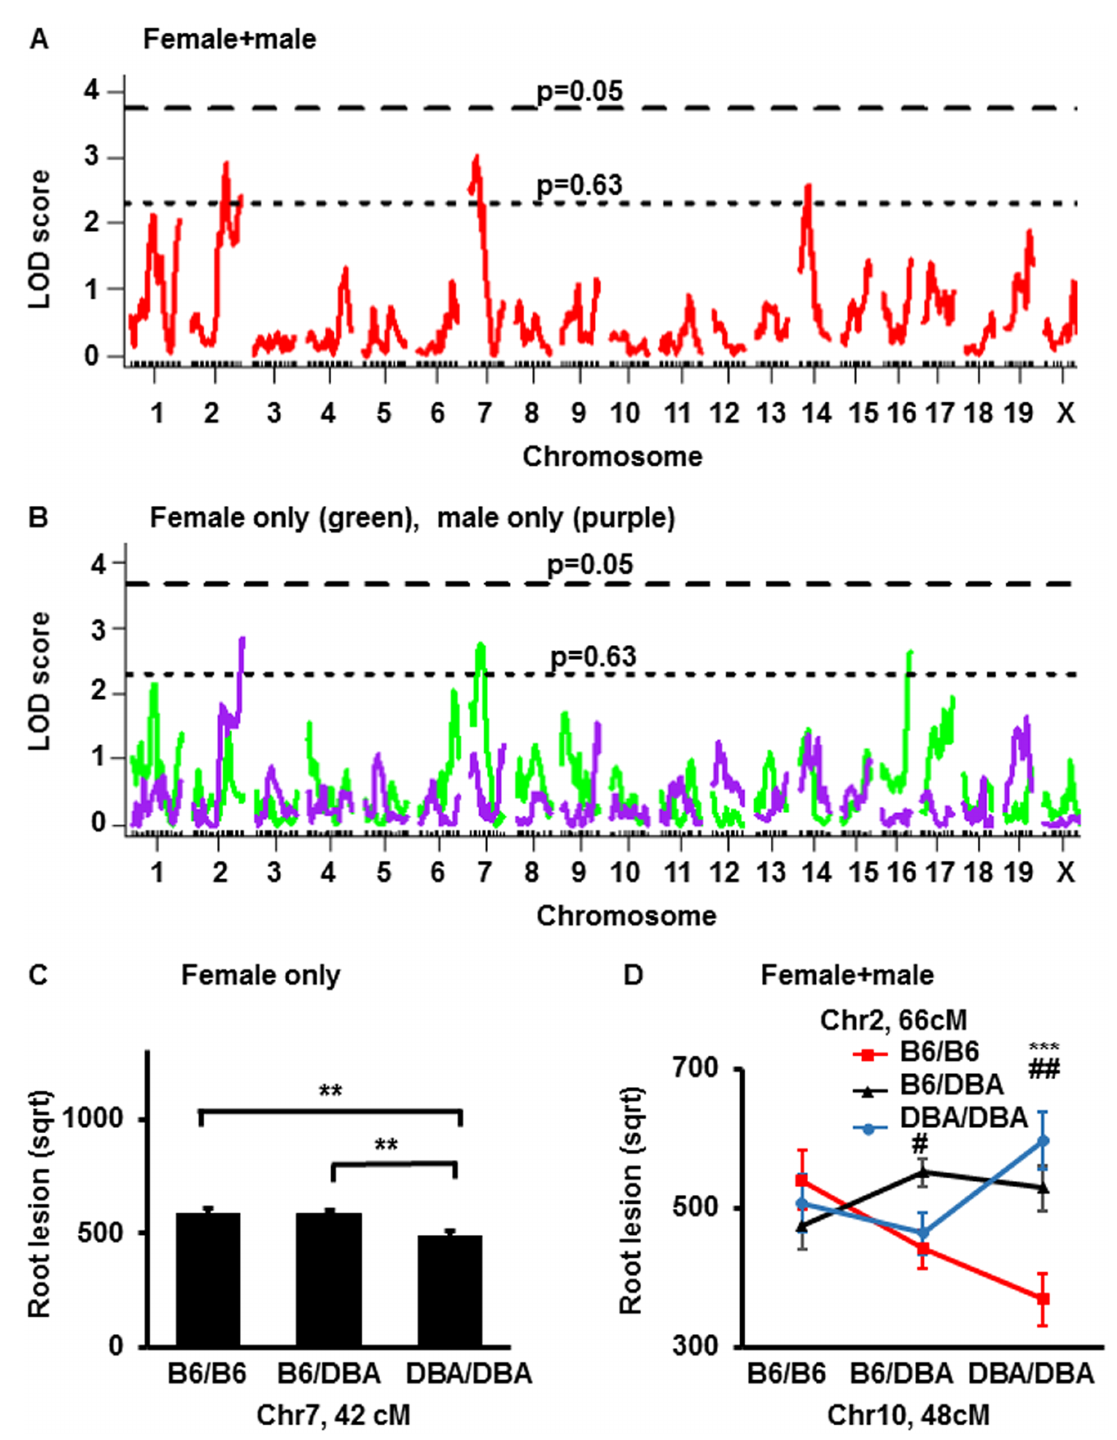
Fig 3. LOD curves and allelic effect of QTL for root plaque size. (A) LOD curve for root lesion size with sex as additive covariatein F2 mice from a cross B6-apoEX DBA-apoE. The horizontaldashed and dotted lines represent thresholdsfor suggestive(p = 0.63) and significant(p = 0.05) QTLs. The significancethresholds for LOD scores were determined by 1000 permutations using R/qtl software. (B) A LOD curve for root lesion size in female-only (green) and male-only(purple)scans in F2 mice from cross B6-apoEX DBA-apoE.The horizontaldashedand dotted lines represent thresholdsfor suggestive (p = 0.63) and significant (p = 0.05) QTLs. The significancethresholds for LOD scores were determinedby 1000 permutations